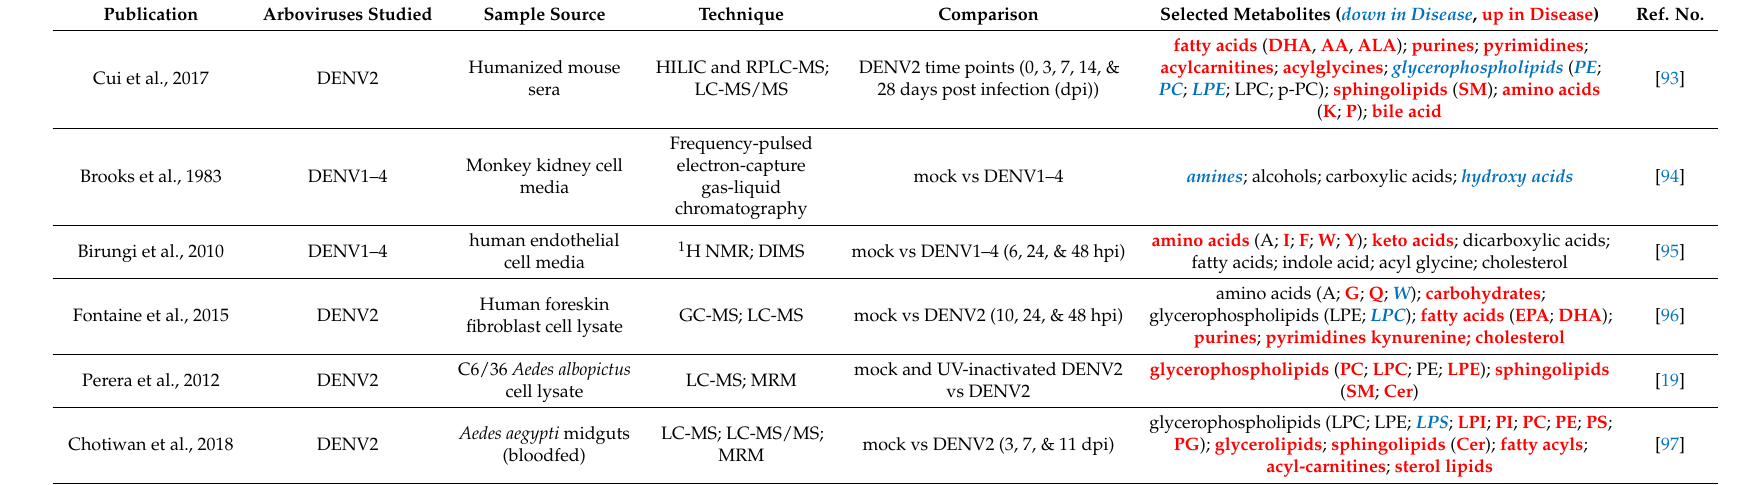
Table 3. Selected metabolites from papers on infection with DENVs in model systems and mosquitoes. Metabolites generally increased in disease are in red, decreased metabolites are in blue. Black metabolites have mixed results in the corresponding publication. If not specified, LC was reversed-phase. Standard single letter amino acid abbreviations are